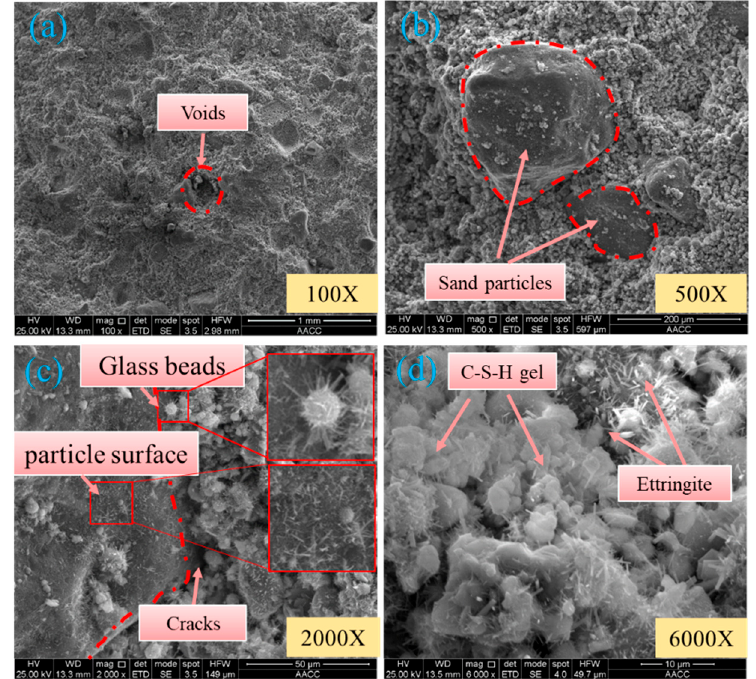
Figure 14. SEM micrographs of microstructure inside filled object for a curing time of 7 days under various magnifications (as indicated in the bottom right-hand corners): ( a ) filled object at 100x magnification ; ( b ) filled object at 500x magnification ; ( c ) filled object at 2000x magnification ; ( d ) filled object at 6000x magnification .